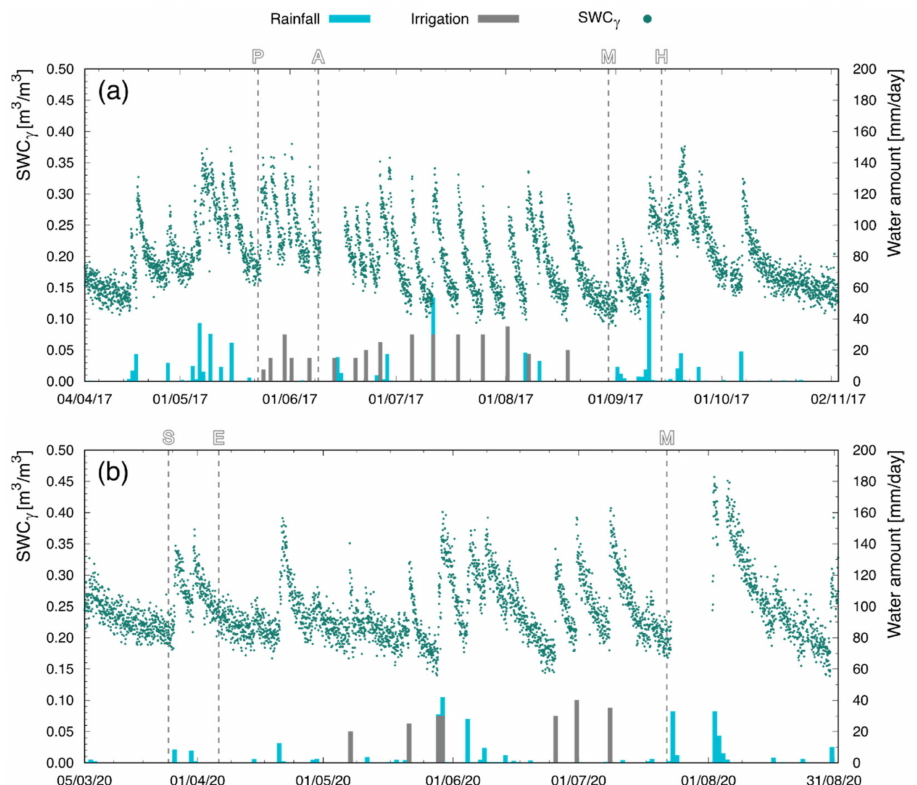
Figure 3. Time series of the volumetric SWC γ estimated by the PGRS in T2017 ( a ) and M2020 ( b ). Letters indicate the crop stages of planting (P), anthesis (A), maturity (M), and harvesting (H) for T2017, and sowing (S), emergence (E), and maturity (M) for M2020. Each green point represents the hourly SWC γ estimated through the analysis of the 40 K signal. The bars represent the daily amount of precipitated water (in mm), where the contributions of rain and irrigation are reported in blue and gray, respectively. The data gaps from 9 to 16 June 2017 and from 23 to 30 July 2020 were caused by system shutdowns due to